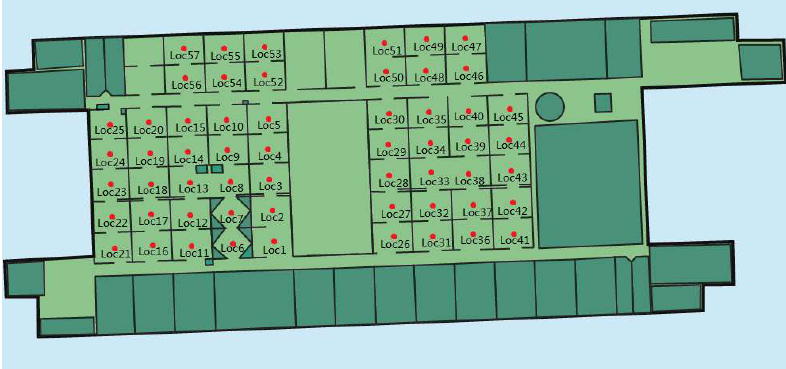
Figure 10. The sample position of the Dataset3 in our